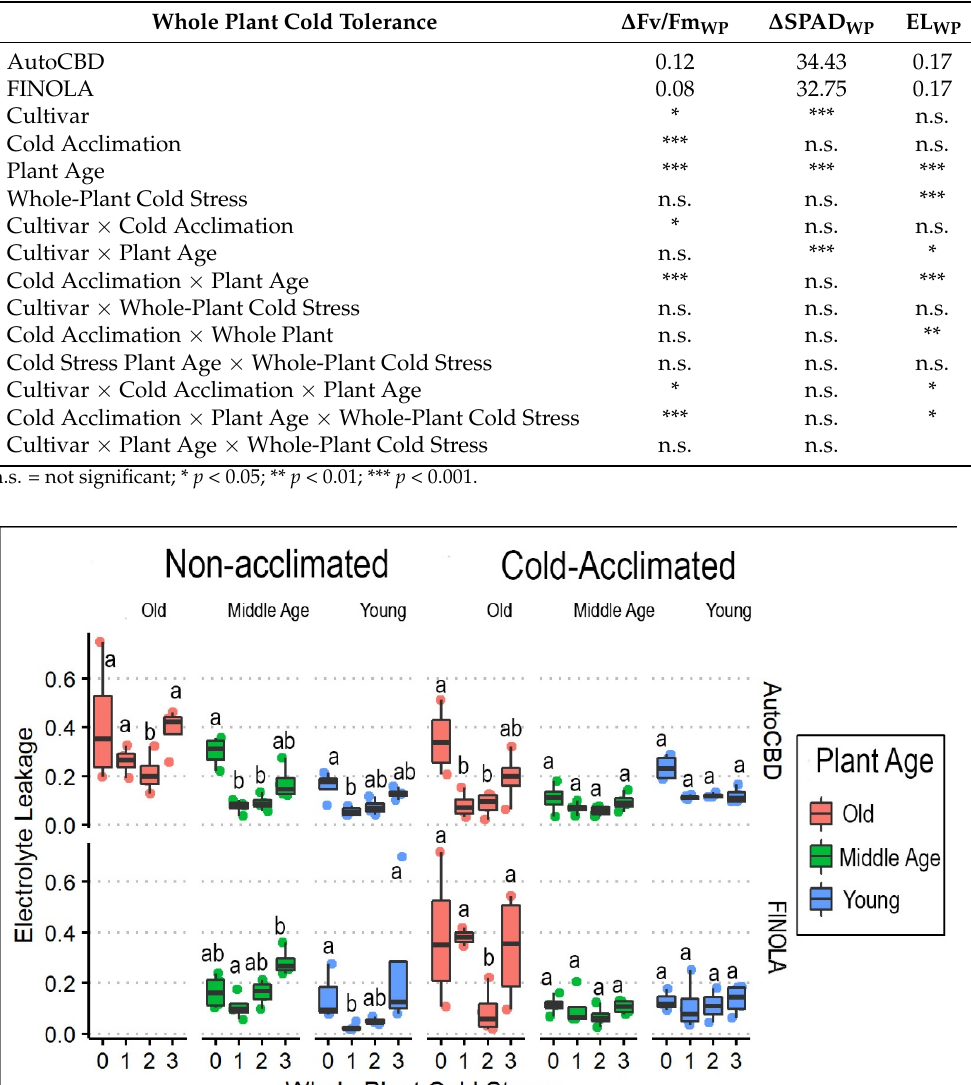
Table 2. Summary of effects of cultivar, cold acclimation, plant age, whole-plant cold stress, and their in- teractions and mean values for ‘AutoCBD’ and ‘FINOLA’. Cold tolerance was quantified with ∆ Fv/Fm WP (difference between Fv/Fm taken prior to and after whole-plant cold stress), ∆ SPAD WP (difference in mean SPAD values taken prior to whole-plant cold stress and after whole-plant cold stress), and EL (ratio between EC of leaf sample after whole-plant cold stress and EC of leaf sample after cell lysis).